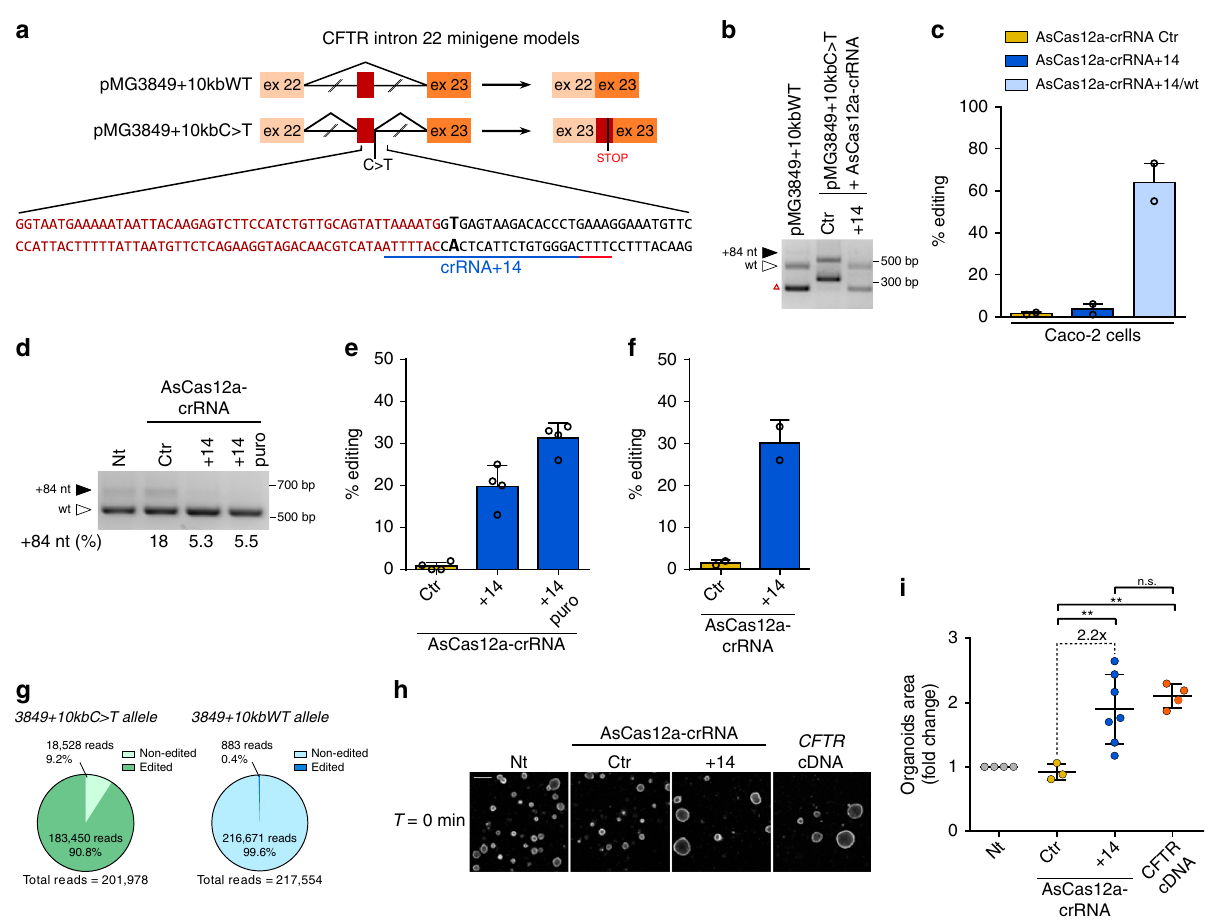
Fig. 4 Correction of 3849 + 10kbC>T splicing defect by AsCas12a-crRNA + 14 editing. a Scheme of CFTR wild type (pMG3849 + 10kbWT) and 3849 +